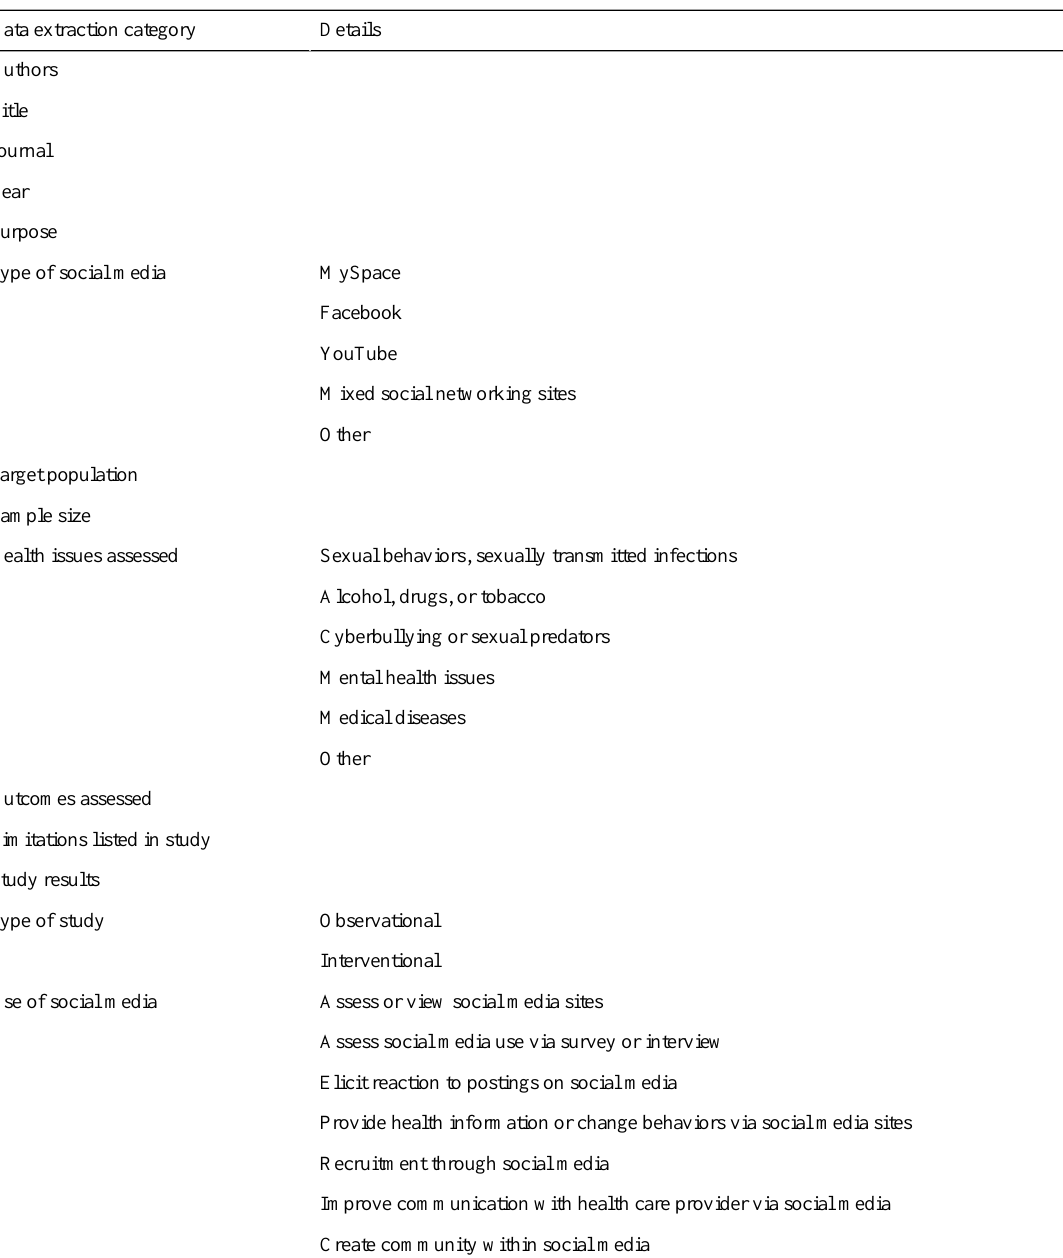
Table 2. Checklist for data acquisition for papers included in the systematic